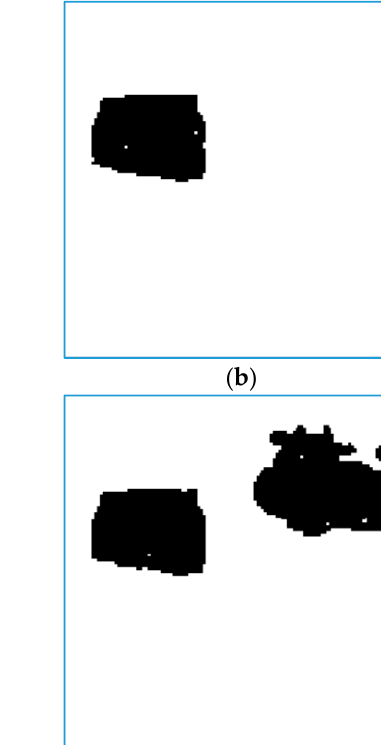
8 of 10 Figure 10. The tampering of Splash image. ( a ) Marked image ; ( b ) Tampered image ; ( c ) Tampered re- gions . Figure 11 shows the results of the second-stage detection with different methods. For